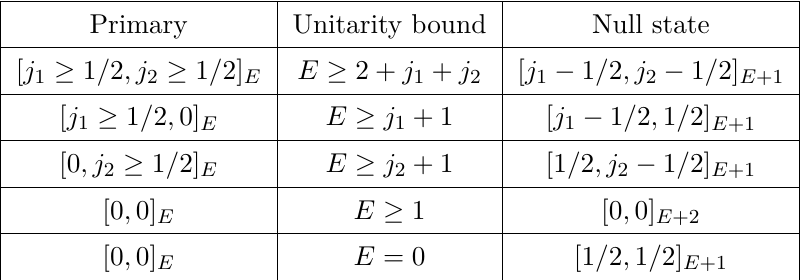
Table 16. Unitary representations of so (4 , 2) . In the final column we list the associated null state when the unitarity bound is saturated. The null states correspond to equations of motion and as such their contribution must be subtracted from the index.